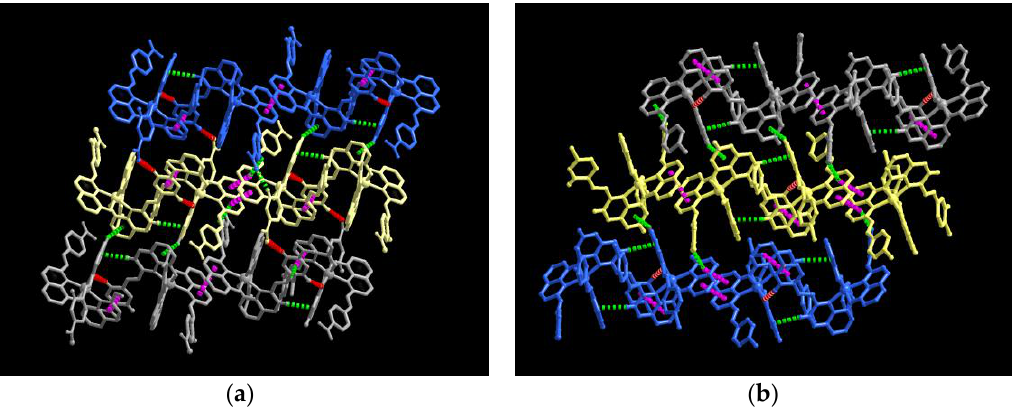
Figure 3. Views of the two-dimensional supramolecular structure of 1 ( a ) and 2 ( b ). (The 1D chains are shown in different colors for clarity, the C-H···O, C-H···π and π···π stacking interactions were highlighted by red, green, and pink dotted lines, respectively).